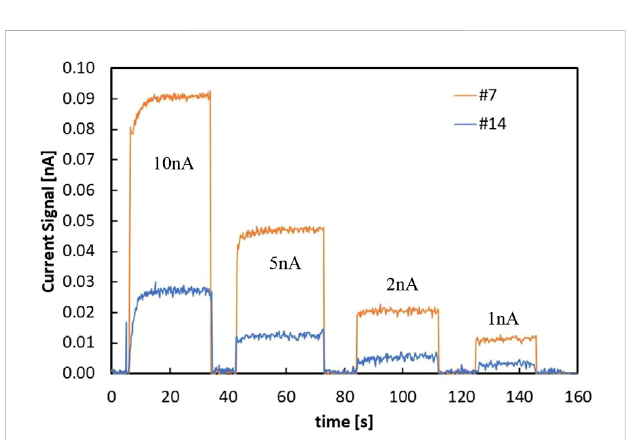
FIGURE 6 Current response of the sample prototype #7, carrying the 1 μ m- thick CsPbCl 3 fi lm on the IDE/Pd substrate measured and of prototype #14, without the CsPbCl 3 fi lm on the same substrate, plotted as a function of time under exposure to a 220 MeV proton beam using different extraction currents: 10-5-2-1 nA (dark current subtracted, applied voltage V = 2 V).